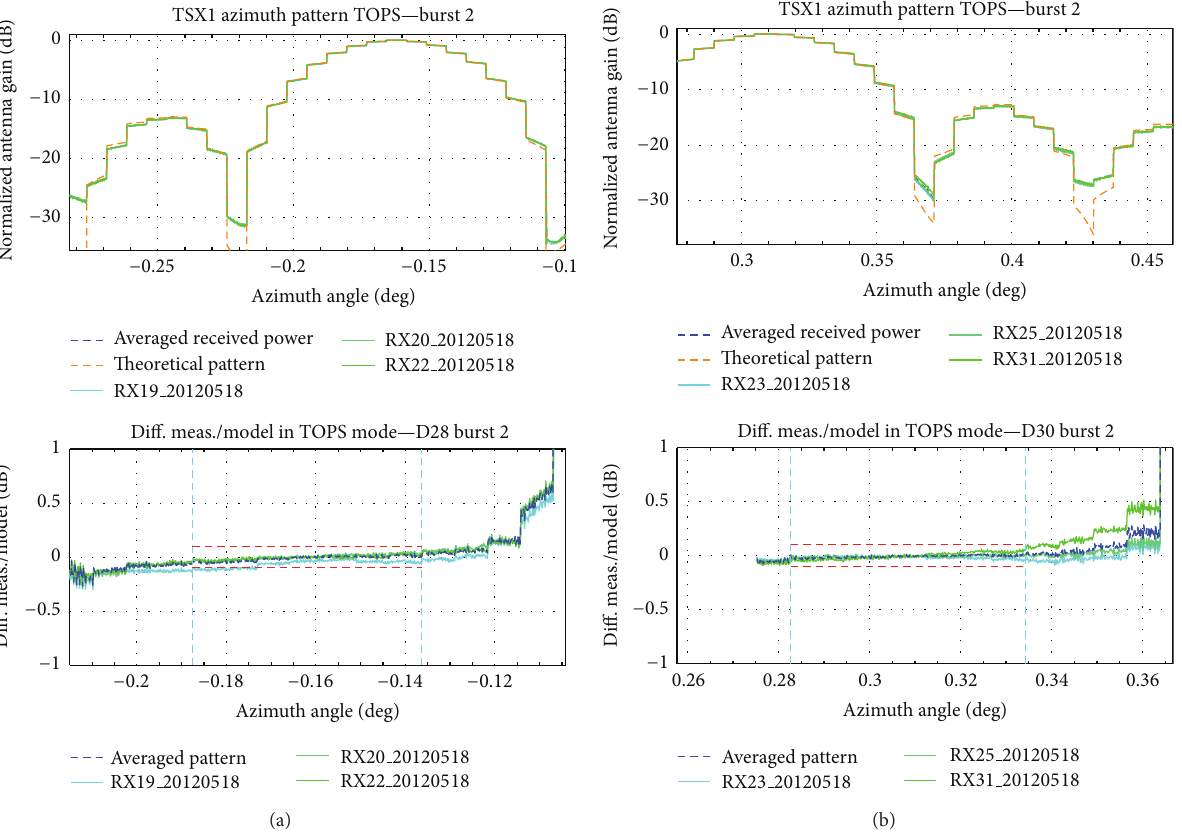
Figure 4: TOPS measurements of burst 2 acquired on May 18, 2012, (a) at test site D28 and (b) at test site D30.